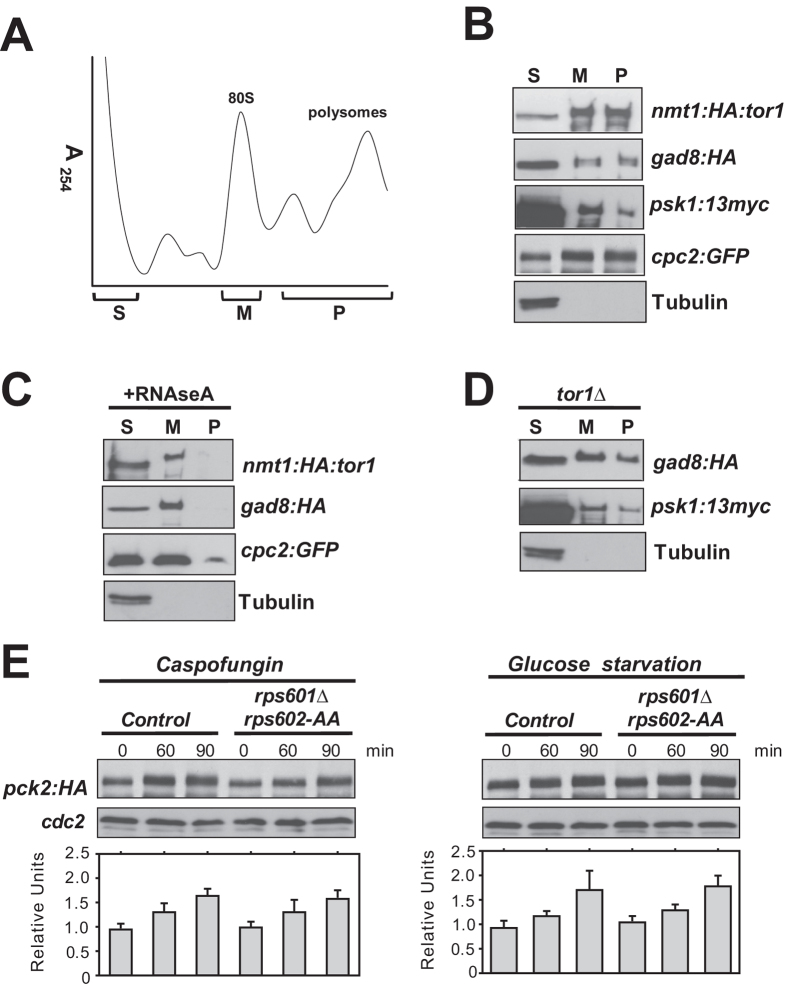
Tor1, Gad8, and Psk1 associate to translating ribosomes, and regulate Pck2 levels during stress independently of Rps6 phosphorylation.(A) Absorbance profile at 254 nm of a representative polysome sucrose gradient. Soluble (S), monosomal (M), and polysomal (P) fractions are indicated. (B) Ribosomes from cycloheximide-treated cultures of strains BA192 (nmt1-HA-Tor1), JW960 (Gad8-HA), AN0179 (Psk1-13myc), and AN071 (Cpc2-GFP; 40 S ribosomal protein), were purified by sedimentation through sucrose gradients. Identical volumes of representative monosomal and polysomal fractions were analyzed by Western blot with either anti-HA, anti-Myc, or anti-GFP antibodies. Anti-tubulin was used as a non-ribosomal negative control. (C) Cell extracts from strains described in (B) were incubated with 0.5 mg/ml RNAse A for 20 min before sucrose sedimentation, and monosomal and polysomal fractions analyzed as above. (D) Western blot analysis of monosomal and polysomal ribosomal fractions from cycloheximide-treated cultures of strains BV397 (tor1Δ Gad8-HA), and BV84 (tor1Δ Psk1-13myc). (E) Growing cultures of strains BV8 (Pck2-HA; control) and BV78 (rps601Δ rps602-AA Pck2-HA) were treated with 1 μg/ml Caspofungin (left panel), or shifted to the same medium without glucose (right panel). Pck2 levels were detected after incubation with anti-HA antibodies. Anti-Cdc2 was used as loading control. *P < 0.05 in mutant strain as compared to the control.